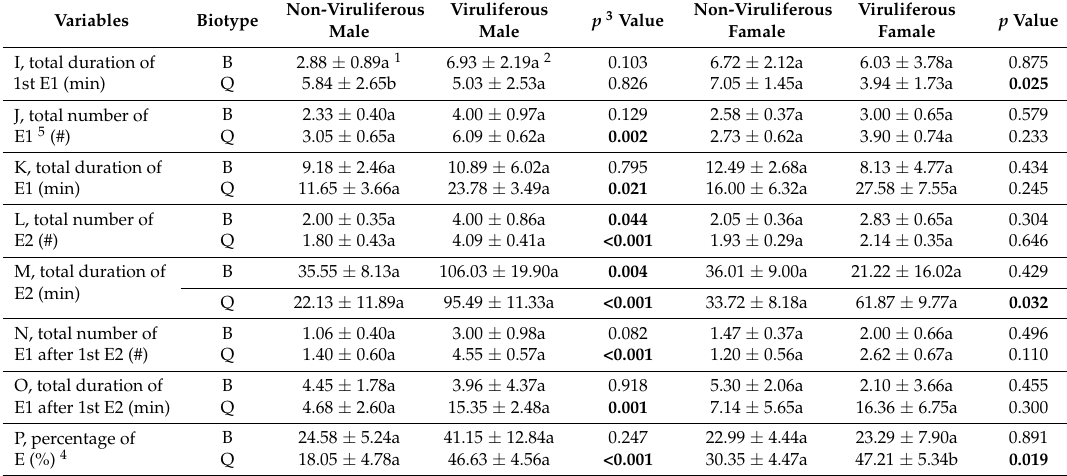
Table 2. EPG phloem variables of different sexes of non-viruliferous and viruliferous B. tabaci B and Q